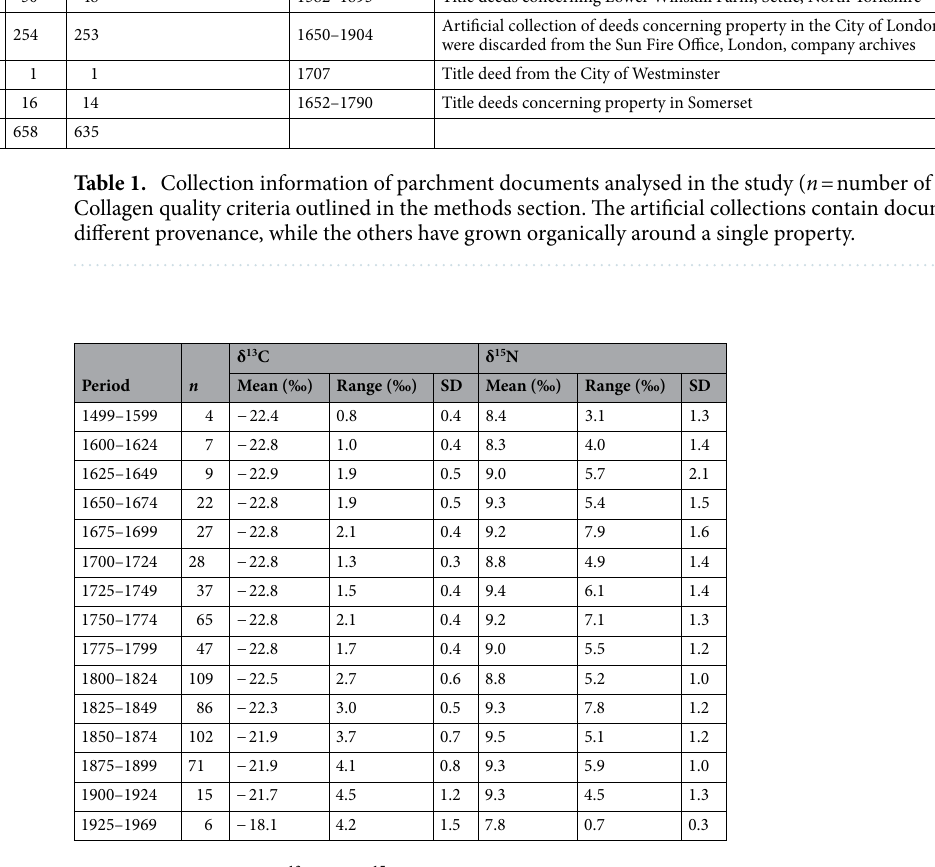
Table 2. Summary of δ 13 C and δ 15 N values by 25-year periods ( n = number of samples). Due to the small sample sizes, parchment dated between AD 1499–1599 and 1925–1969 are presented as single